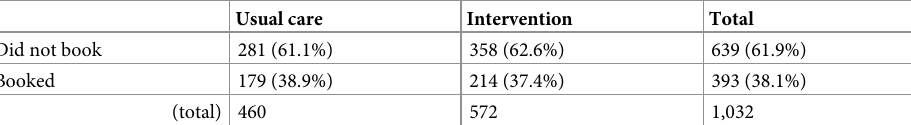
Table 1. Frequency and proportion of booking a screening appointment within 14 days in the letters trial. Usual care